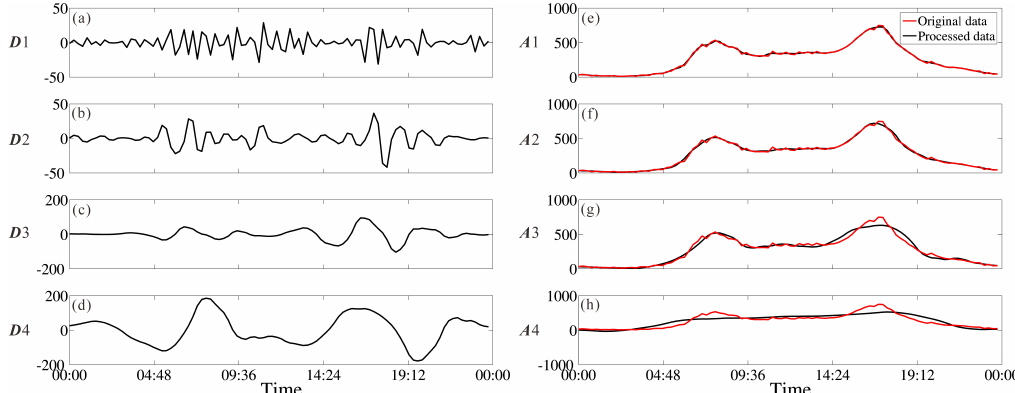
Figure 8. This is a figure, Schemes follow the same formatting. If there are multiple panels, they should Figure 8. Noise separated from the tra ffi c flow measurement data using the discrete wavelet be listed as: ( a ) Description of what is contained in the first panel. ( b ) Description of what is contained transform (DWT) method: ( a – d ) noises separated from i -level decompositions; ( e – h ) original data and in the second panel. Figures should be placed in the main text near to the first time they are cited. A approximated data from i -level caption on a single line should be centered.